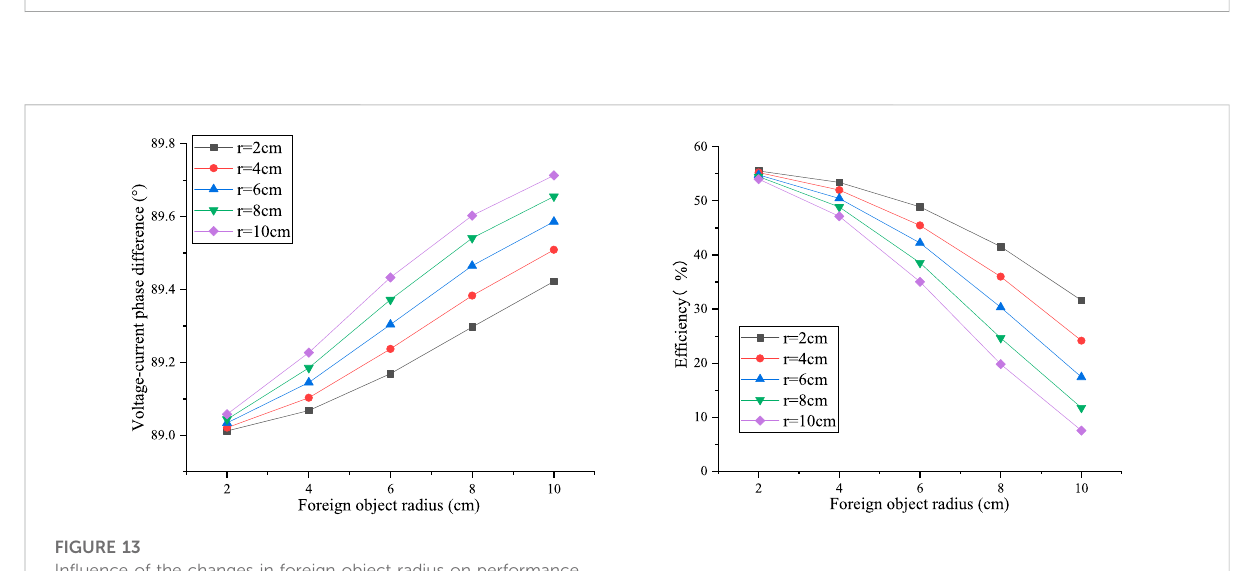
FIGURE 13 In fl uence of the changes in foreign object radius on